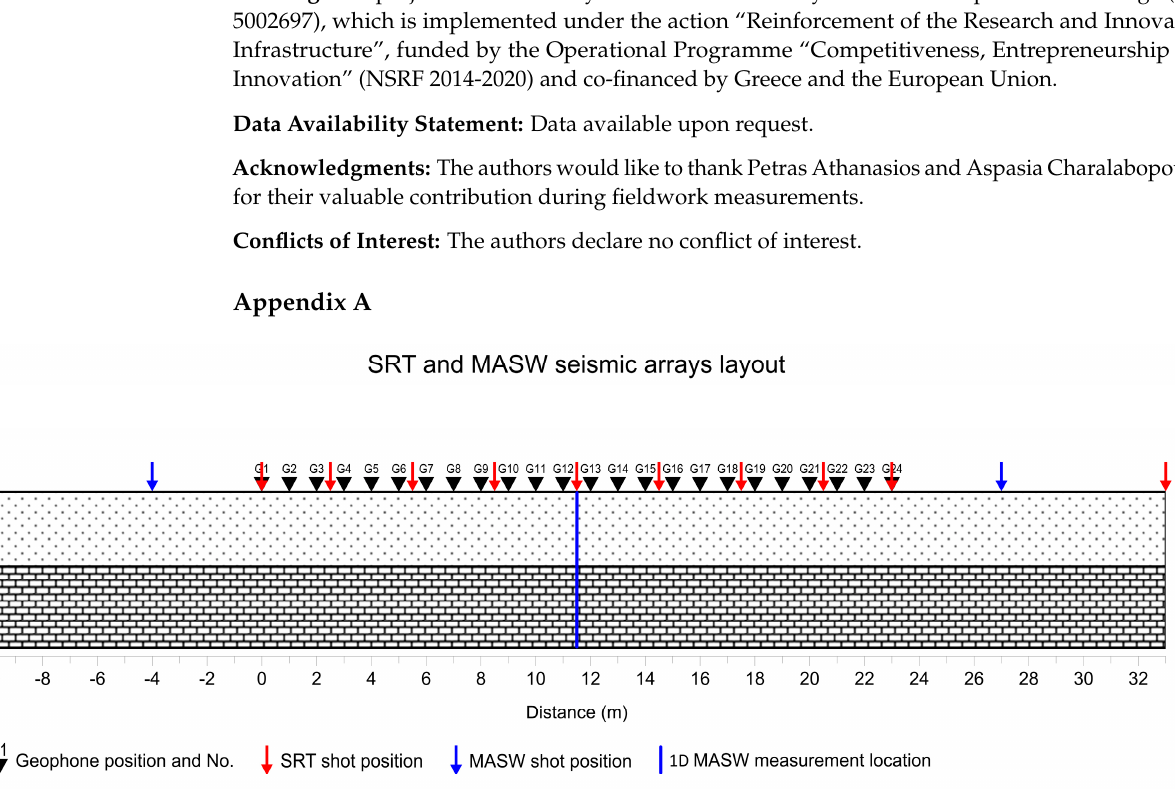
Figure A1. Sketch illustrating the locations of the shots and the arrangements of the geophones for the SRT and MASW seismic arrays.